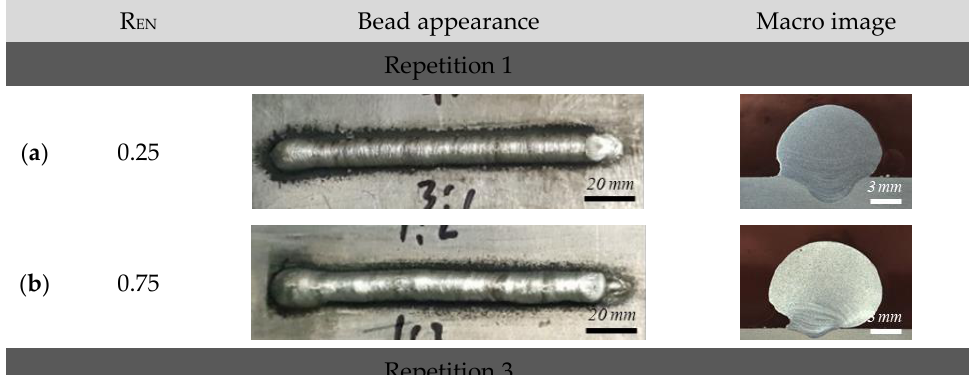
Figure 9. Observation of droplet transfer and molten pool deformation throughout the EP ( i – v ) and EN ( vi – x ) phases. The images were captured under the conditions of a welding speed of 0.3 m/min, five pulse repetitions, and an R EN of 0.5.